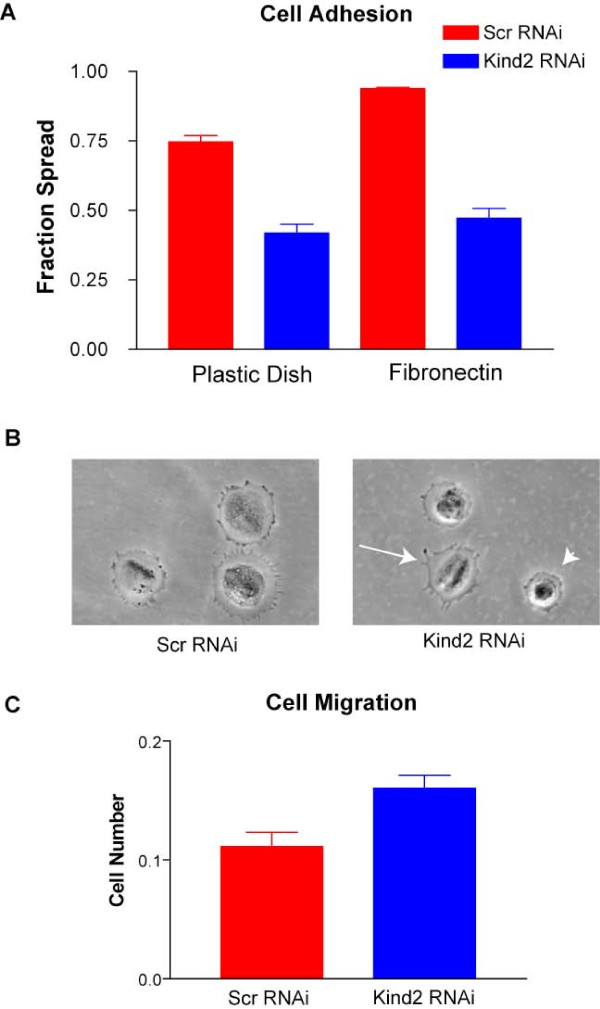
Kindlin-2 knockdown alters C2C12 adhesion and migration. A. Day 2 differentiated myocytes were plated onto either non coated or fibronectin coated cell culture dishes and incubated for 1 hour at 370C. Cells were fixed and then examined for morphologic changes consistent with adhesion and spreading. On non coated dishes, percent spreading was 71.6% (+/-0.02%) for scrambled and 41.8% (+/-0.03%) for kindlin-2 RNAi (p < 0.0001, n = 5). On fibronectin, percent spreading was 93. 8% (+/-0.01%) for scrambled and 47.2% (+/-0.03) for kindlin-2 RNAi (P < 0.0001, n = 5). B. Bright field photomicrograph taken at 10× of representative cells from the assay described in A. The arrow points to a spread cell while the arrowhead points to a non-spread cell in kindlin-2 RNAi transfectents. C. RNAi transfected C2C12 cells were replated onto transwell and allowed to migrate through the wells to a lower chamber filled with media. Migrated cells were counted after 12 hours. Significantly more migration was observed with kindlin-2 knockdown (scrambled v kindlin-2 RNAi, 0.11+/-0.01 v 0.16+/-0.01; p = 0.019; n = 3).